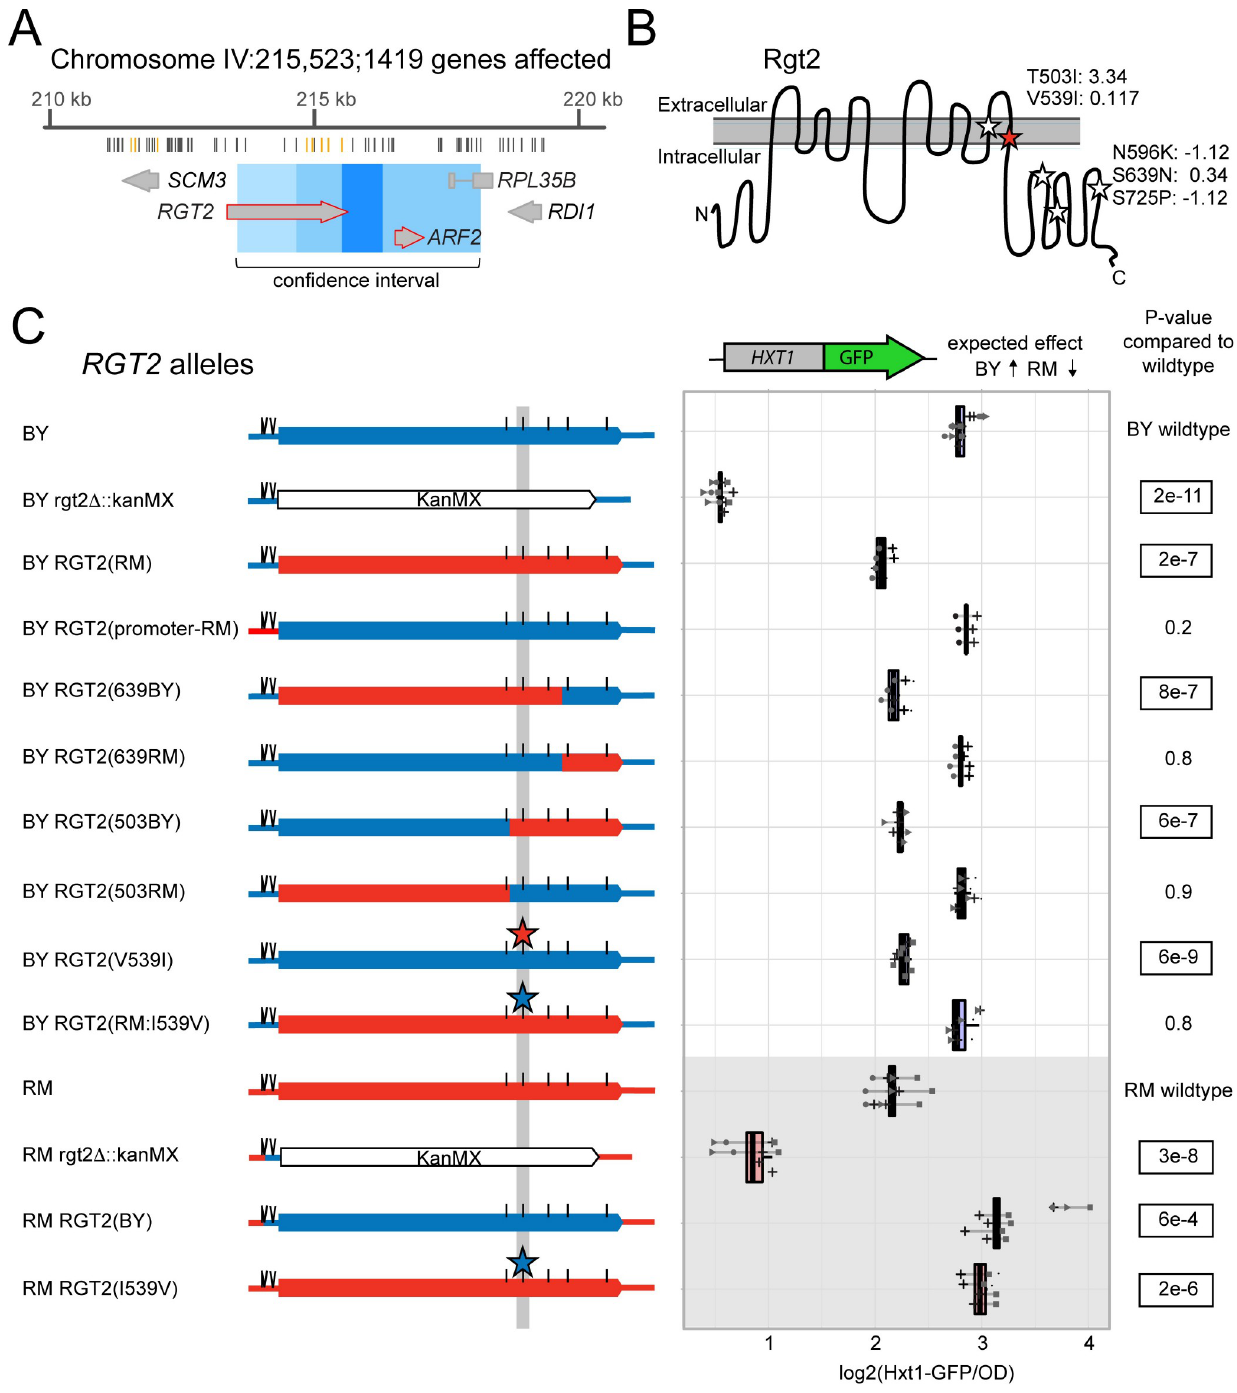
Fig 2. Fine mapping the causal variant in RGT2 . A. Schematic of the eQTL hotspot on Chromosome IV. From top to bottom, the figure shows the hotspot location on the chromosome and the number of genes it affects, the positions of the BY and RM sequence variants (gray lines mark synonymous and intergenic variants and orange lines mark missense variants), the genes and their positions in the hotspot (large gray arrows; red outlines denote genes with a local eQTL) The 90% confidence interval (light blue), 95% confidence interval (medium blue) and the position of markers perfectly linked to the hotspot peak marker (dark blue). Modified from Supplementary File 5 in [12]. B. Schematic of the Rgt2 protein in the plasma membrane. BY / RM missense variants are indicated by stars, with the identified causal variant in red. The missense variant amino acid positions, their resulting amino acid change and their PROVEAN scores [53] are shown. The synonymous variants are not depicted. C. On the left are schematics of RGT2 alleles with BY sequences in blue and RM sequences in red. Positions of SNVs are marked with a straight line and INDELs are marked with two diagonal lines. The